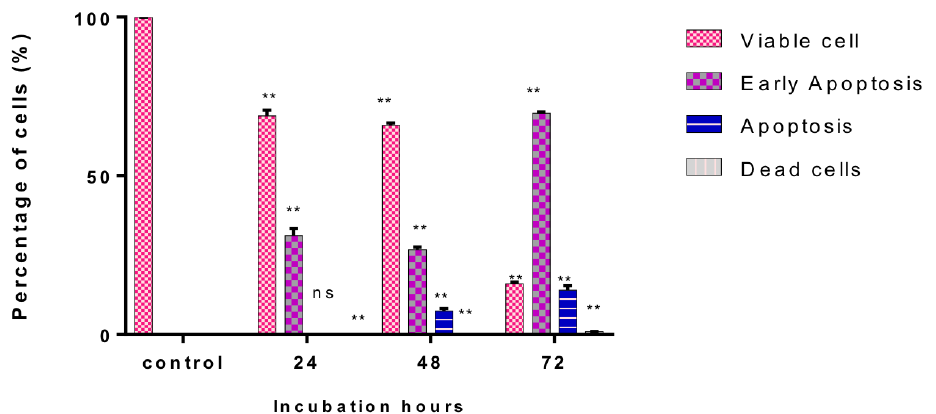
Figure 6 . Time dependence of apoptosis rate of exposed PC-3 cell line. Each treatment and control shows the percentage of dead, viable, early apoptosis, and late apoptosis cells. Incubation time for control was the same as treated cell, which were 24 h, 48 h and 72 h. The data represented mean ± standard deviation (SD) of three independent experiments ( n = 3). Statistical analysis is expressed as ** p < 0.001 and ns is non-significant.